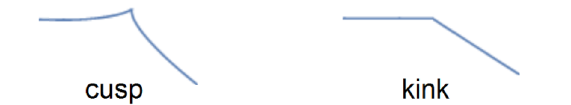
Figure 2 . Terminology used in the paper: cusps & kinks on the string. At the location of cusps the string normal vector changes sign. They correspond to solitons in the sinh-Gordon theory and have a topological charge. Kinks connect elementary string segments and move with the speed of light. There is no charge associated to these